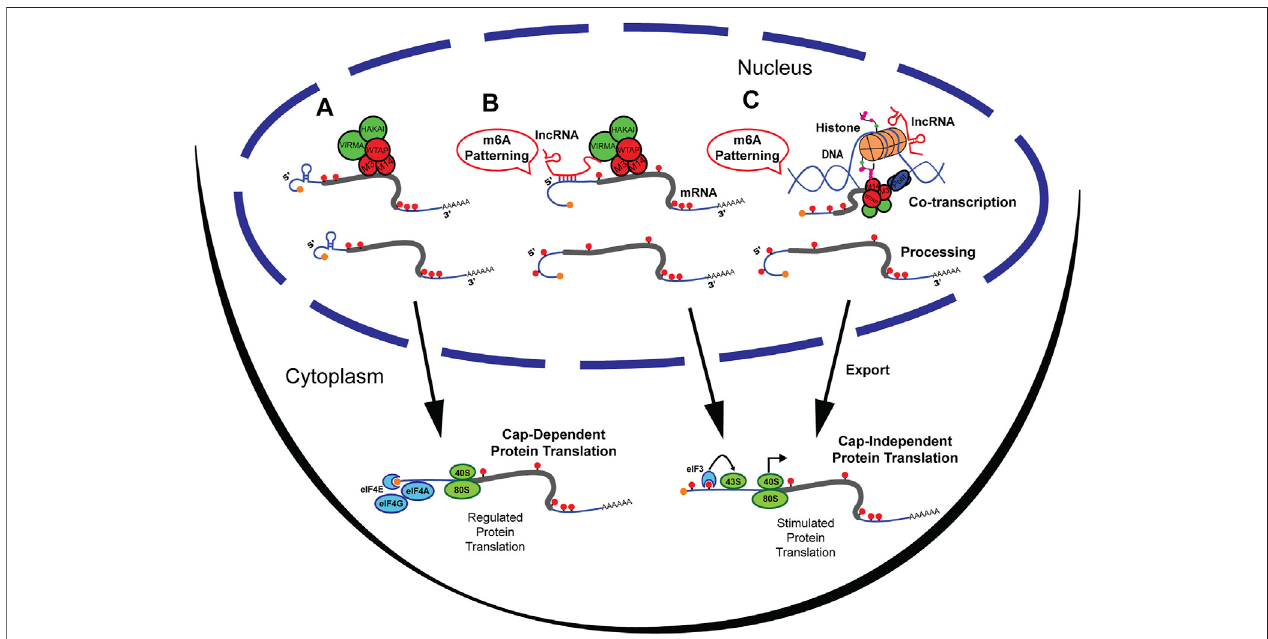
FIGURE1| M 6 AmethylationattheUTRscanbepatternedbylncRNAs. (A) M 6 AmethylationbywritercomplexoccurringprimarilyattheCDSand3 ′ UTRofmRNA. Methylated mRNA is then exported from the nucleus and undergoes cap-dependent protein translation. (B) LncRNAs directly guide the m 6 A Writer complex by associationwithVirmatopatternthe5 ′ UTRwithm 6 A.Uponexport,5 ′ UTRmethylatedmRNAundergoesCap-independentproteintranslationbyrecruitmentofeiF3and bypassing regulatory networks. (C) LncRNAs can recruit histone modifying enzymes that result in m 6 A patterning. Transcripts are then exported from the nucleus and mRNAs methylated at the 5 ′ UTR undergo Cap-independent protein translation.